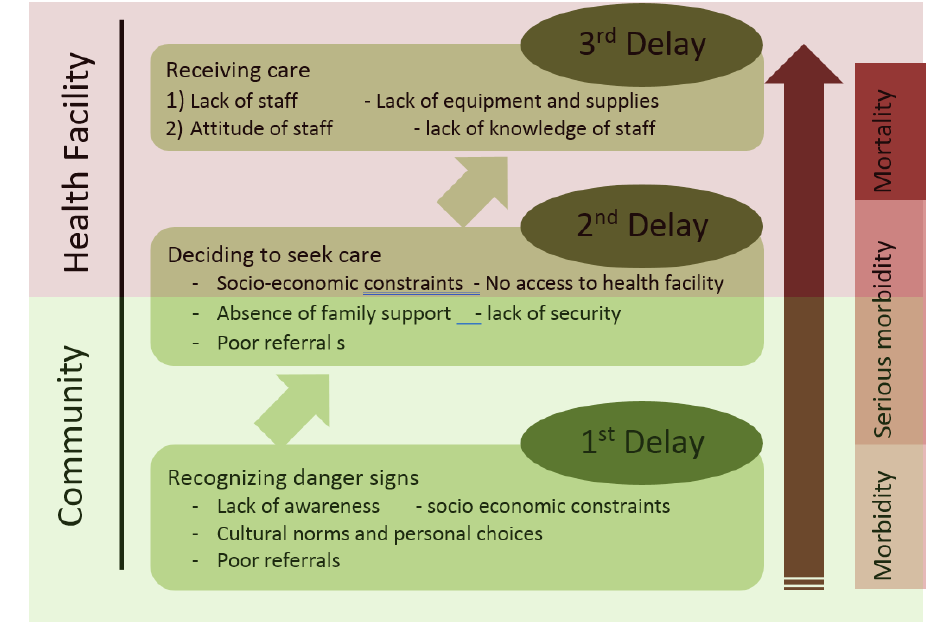
Figure 2. Factors associated with delays in seeking care for maternal and newborn